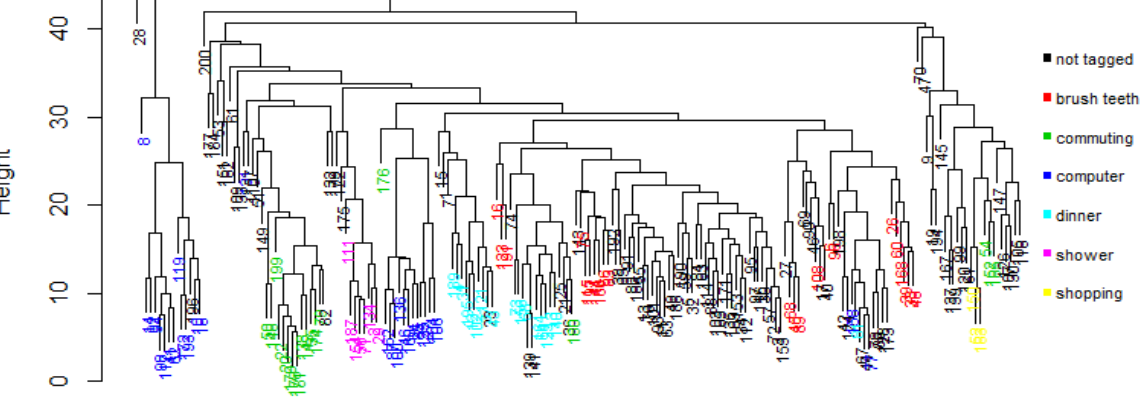
Figure 6. Resulting dendrogram of hierarchical clustering for subject